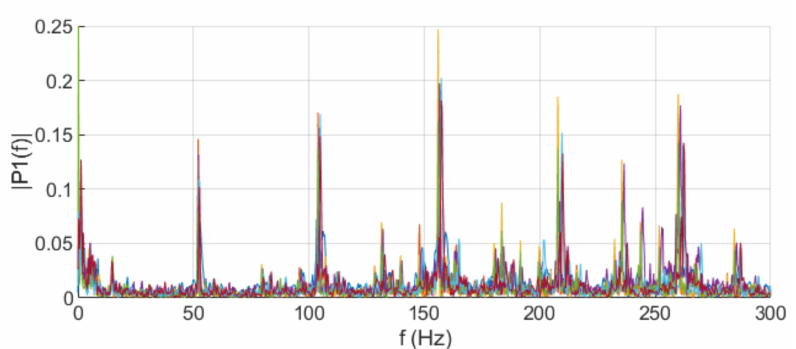
Figure 6. Single-sided amplitude spectrum of the force data when the grinding wheel spins at 3000 rpm (50